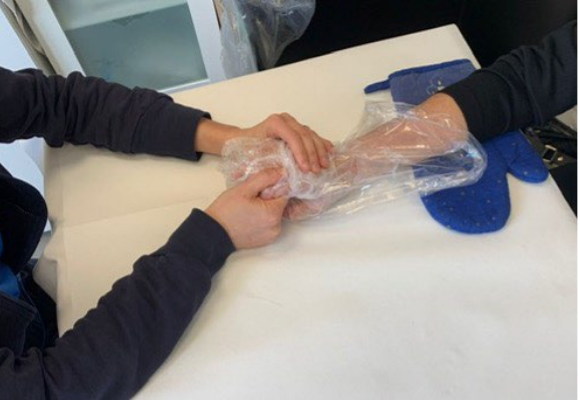
Figure 3. Illustration of a session of paraffin thermal therapy performed within Path A rehabilitative protocol.